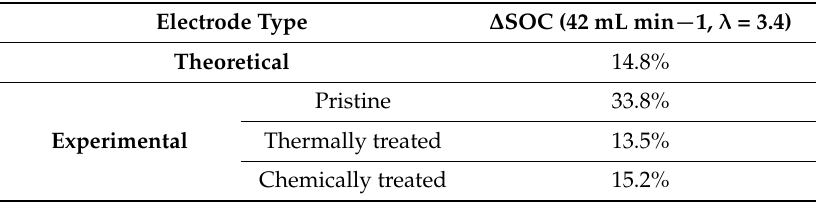
Figure 3. OCV contours at 5 s after termination of discharge at 80 mA cm − 2 for ( a ) pristine, ( b ) chemically modified and ( c ) thermally modified electrodes. The flow of electrolyte was 42 mL min − 1 . Table 2. Theoretical and experimental ∆ SOC for the pristine and modified